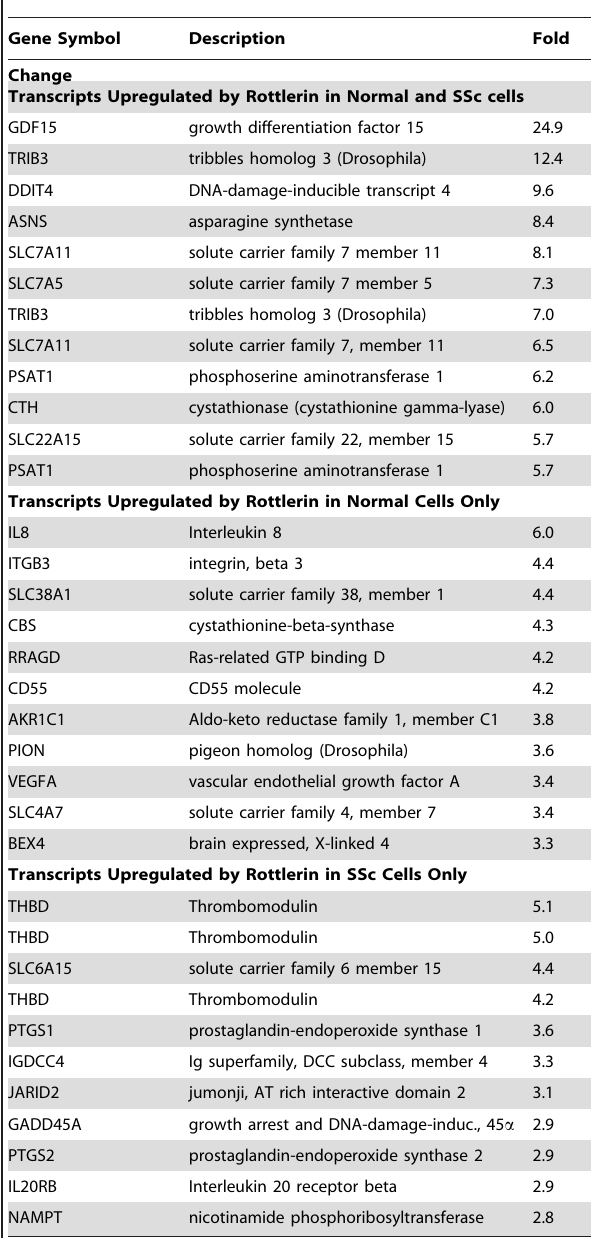
Fold change indicates the difference between untreated normal or SSc cells compared to rottlerin treated normal or SSc cells. The entire dataset discussed in this paper is deposited at Gene Expression Omnibus (http://www.ncbi.nlm. nih.gov/geo/query/acc.cgi?acc=GSE23741) under accession number